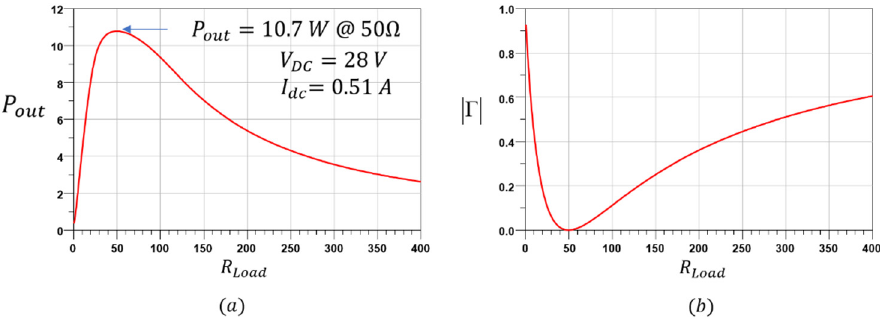
Figure 21. Practical transmission system with a 50 Ω load as an antenna.